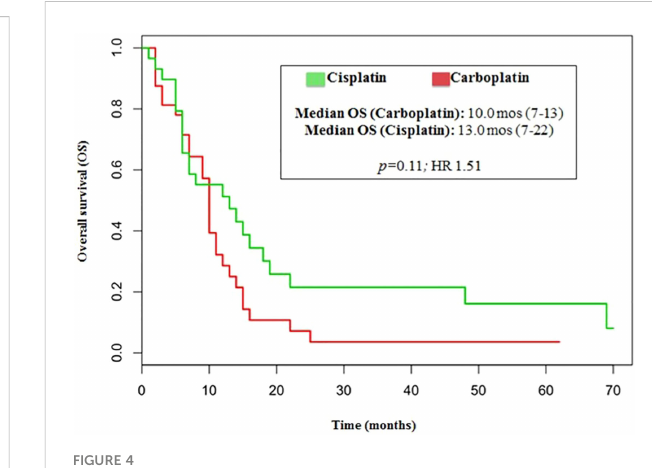
FIGURE 4 Median OS related to cisplatin/etoposide scheme and carboplatin/ etoposide